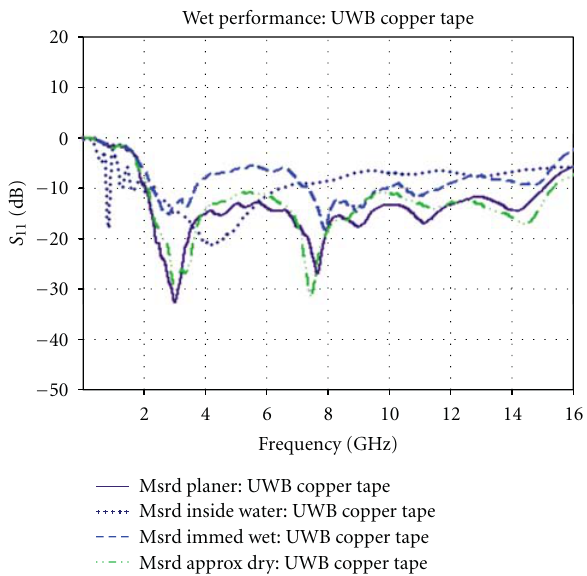
Figure 14: Measured ( | S 11 | ) results of UWB antenna prototype using copper conducting sheet considering several wet conditions.